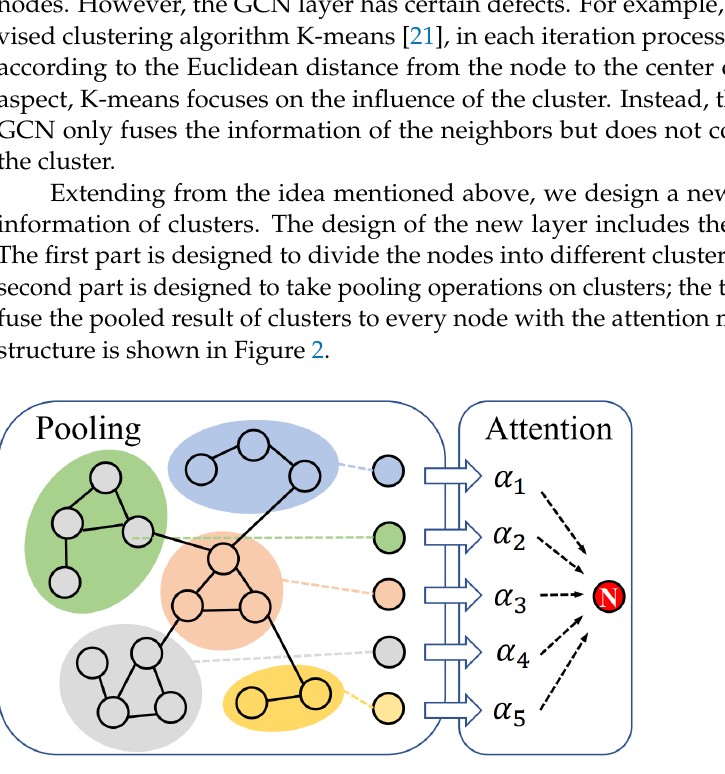
Figure 2. Design of the third layer. On the left part, we divide nodes into different clusters and then perform pooling. On the right part, we use the attention mechanism to fuse pooled